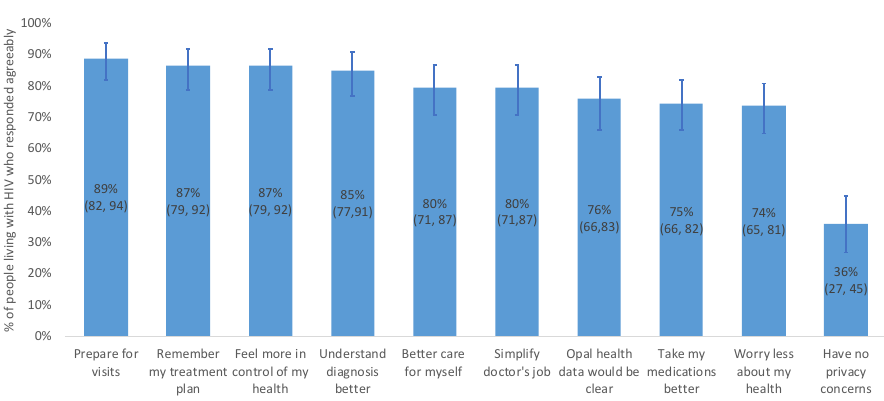
Figure 3. People living with HIV who responded agreeably to anticipated benefits and inconveniences of Opal. Percentages are displayed with 95% confidence intervals in brackets.